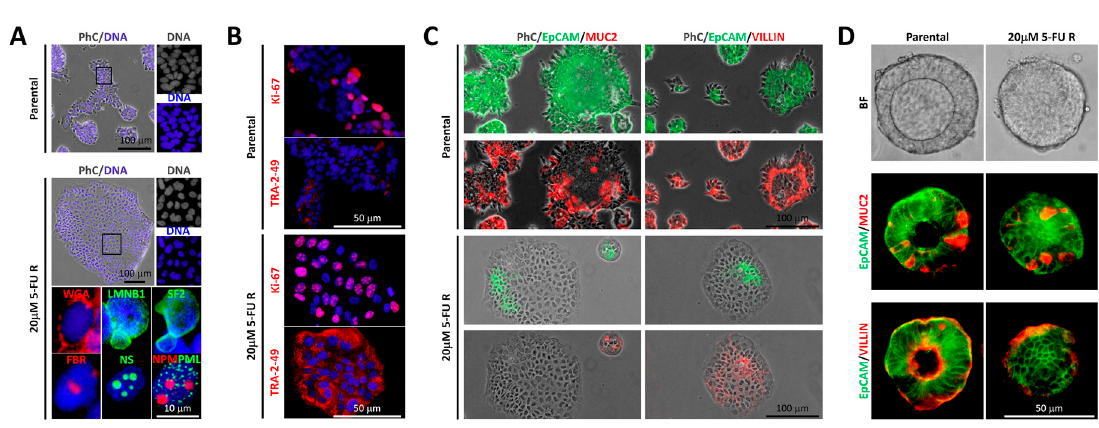
Figure 2. Features of the human colorectal cancer (CRC) stem-like cell line Tu42 under low 5-FU doses. ( A ) Merged images of phase contrast (PhC) and Hoechst-stained nuclei (DNA) of parental (top) or 20 µ M 5-FU resistant (center) Tu42 cells. Boxed areas are shown on the right at higher power and indicate the presence of distinct large foci in response to low-dose 5-FU. Immunofluorescence staining for Wheat germ agglutinin (WGA), Laminin B1 (LMNB1), SF2, Fibrillarin (FBR), Nucleostemin (NS), Nucleophosmin (NPM), or PML in 20 µ M 5-FU resistant Tu42 cells (bottom) suggested high nucleus-to-cytoplasm ratio, the presence of nuclear buds, and identified the previously observed foci as nucleolar structures. Nuclei were counterstained using Hoechst. Pictures are representative of three independent experiments. ( B ) Immunofluorescence staining for Ki-67 or TRA-2-49 of parental (top) or 20 µ M 5-FU resistant (bottom) Tu42 cells indicated the accumulation of Ki-67 in nucleolar regions of resistant cells and the upregulation of TRA-2-49 in the same cells with respect to parental cells. Nuclei were counterstained using Hoechst. Pictures are representative of three independent experiments. ( C ) Merged images of phase contrast (PhC), EpCAM, and Mucin2 (Muc2), or PhC, EpCAM, and Villin of parental (top) or 20 µ M 5-FU resistant (bottom) Tu42 cells indicated that resistant cells downregulate EpCAM, Muc2, and Villin, as compared to parental cells. Pictures are representative of three independent experiments. ( D ) Bright field (BF) images of live unstained parental (top left) or 20 µ M 5-FU resistant (top right) Tu42 cells forming organoids in Matrigel, and immunofluorescence staining for EpCAM / Muc2 (center) or EpCAM / Villin (bottom) in their respective frozen sections indicated resistant cells reacquire EpCAM expression in three-dimensional (3D) cell culture but fail to generate organoids with a central lumen. Pictures are representative of three independent experiments.